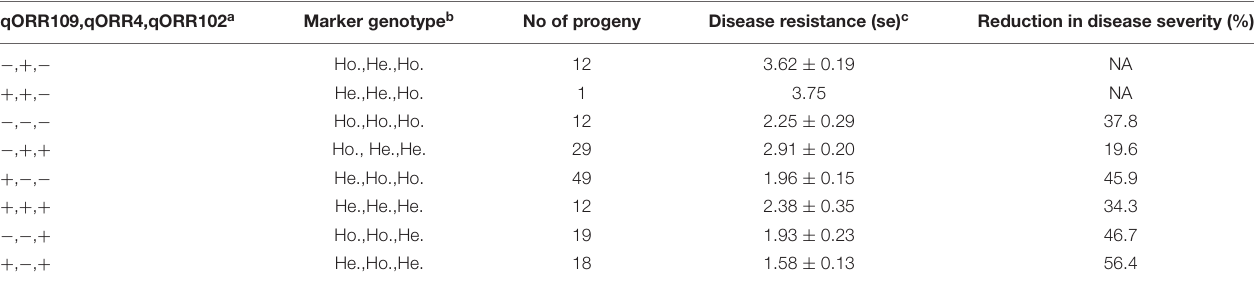
a Symbols “ + ”and “ − “represent presence and absence of corresponding QTL, respectively. b Genotypes of the nearest marker for corresponding qORR109, qORR4, and qORR102. He., Heterozygous genotype. Ho., Homozygous genotype. c Se, standard error. d Reduction in disease severity compared with the mean severity of 12 progeny carrying three susceptible